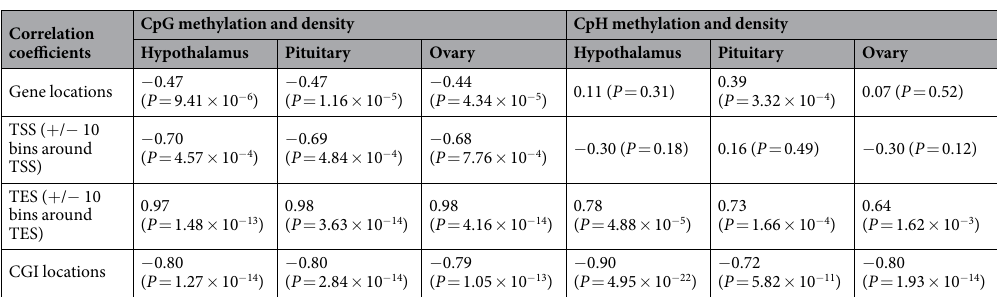
Table 1. Correlation coefficients of DNA methylation with CpG and CpH densities. Correlation coefficients were calculated by Pearson’s correlation. Gene locations extended from Up5k to Down5k. CGI locations extended from Up2k to